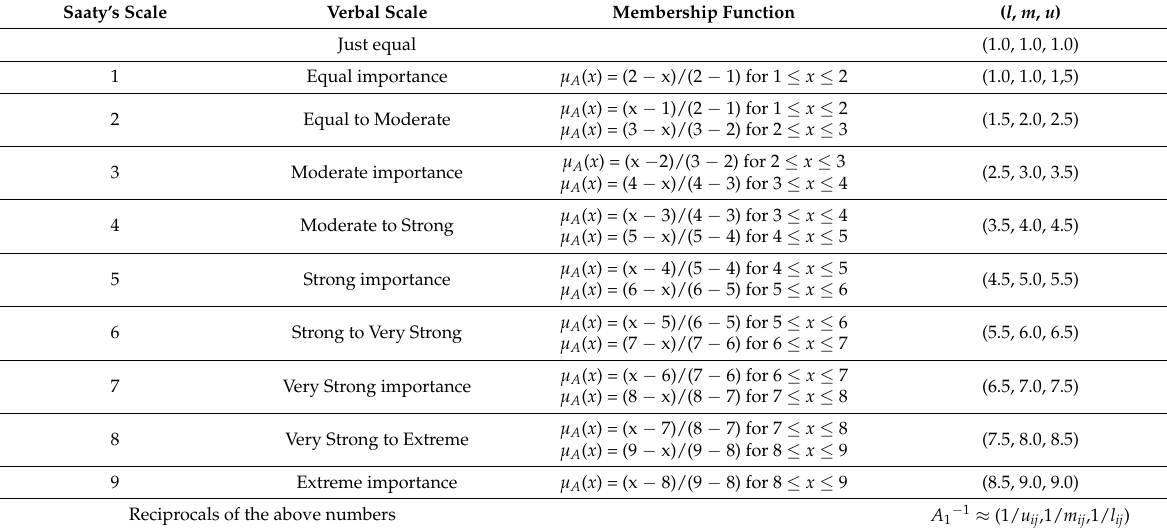
Table 4. Fuzzy measure incorporation in Saaty’s fundamental